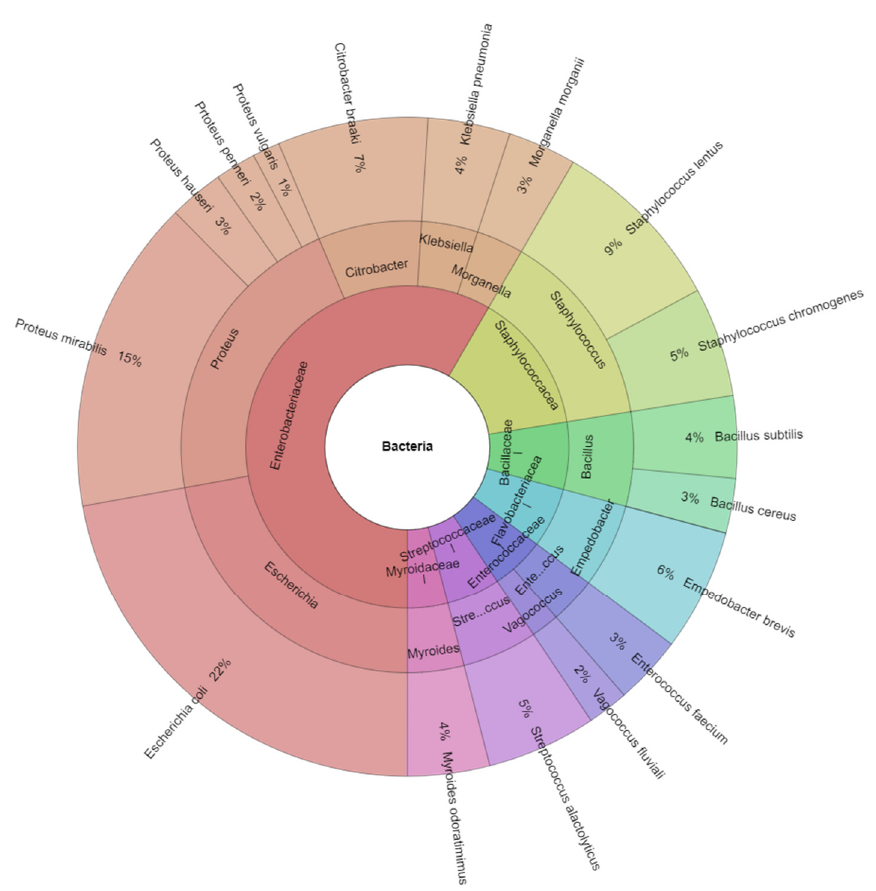
Figure 1. Krona chart of the bacteria represented by MALDI-TOF MS Biotyper recovered from turkey semen (outermost ring: species, middle ring: genus, innermost ring: family). Table 1. Resistance profiles of bacteria found in turkey